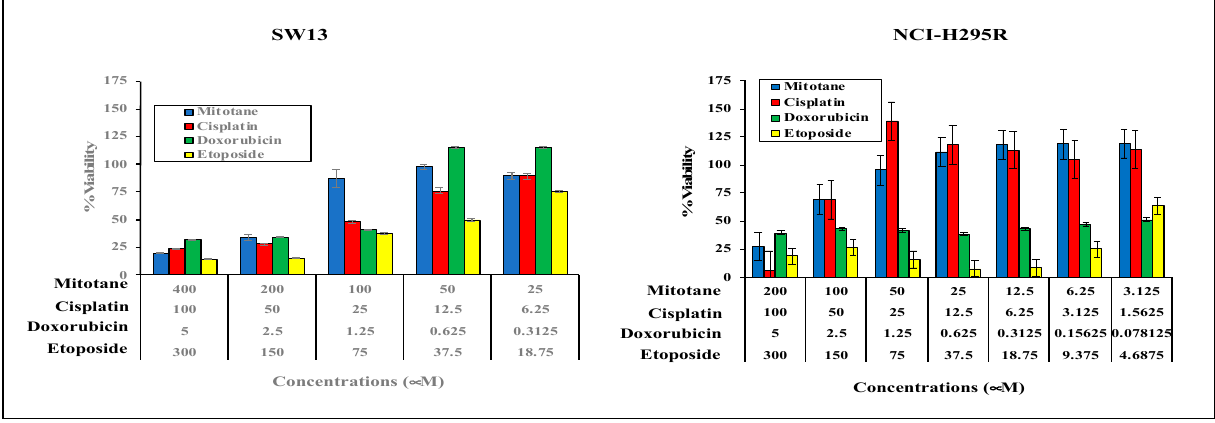
Figure 1. Two ACC cell lines (NCI-H295R and SW13) were treated with varying concentrations of either mitotane, cisplatin, or doxorubicin or etoposide for 72 h and the viability of cells was measured by MTS assay. Percentage viability of cells with respect to untreated control was calculated. Experiments were repeated twice in triplicate, and the values are presented as mean ± standard deviation.